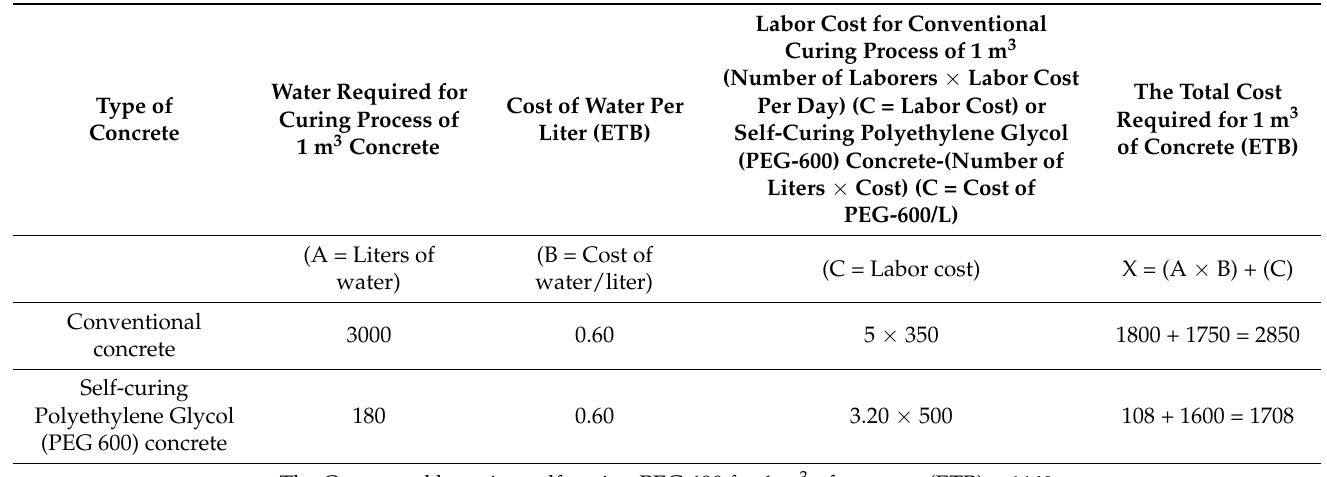
Table 8. Estimation for curing process of conventional and self-curing polyethylene glycol (PEG- 600)